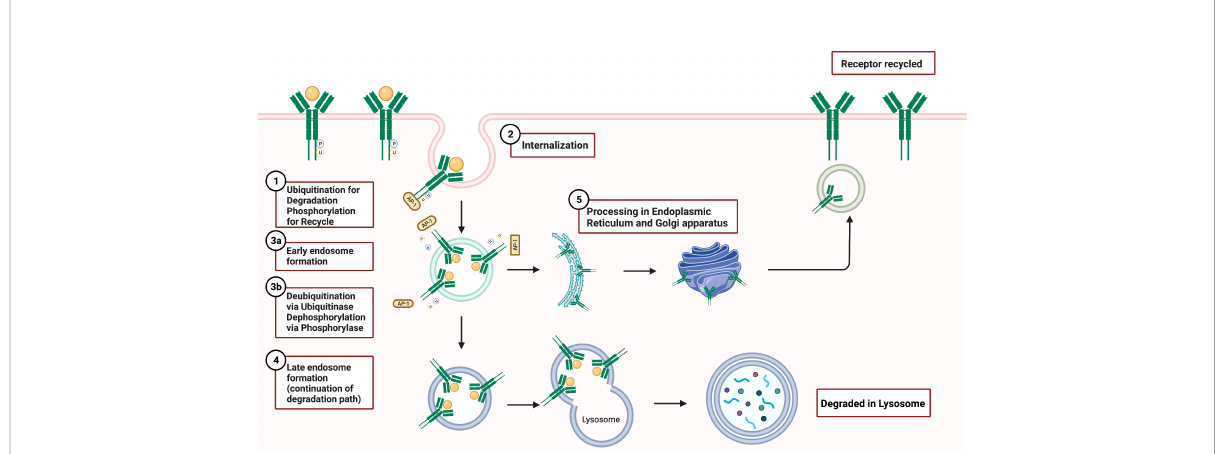
FIGURE 6 GCSFR Degradation and Recycle Mechanisms. Adapted from “ Endocytosis and Exocytosis with Membrane Rupture (Layout) ” , by BioRender.com (2022). Retrieved from